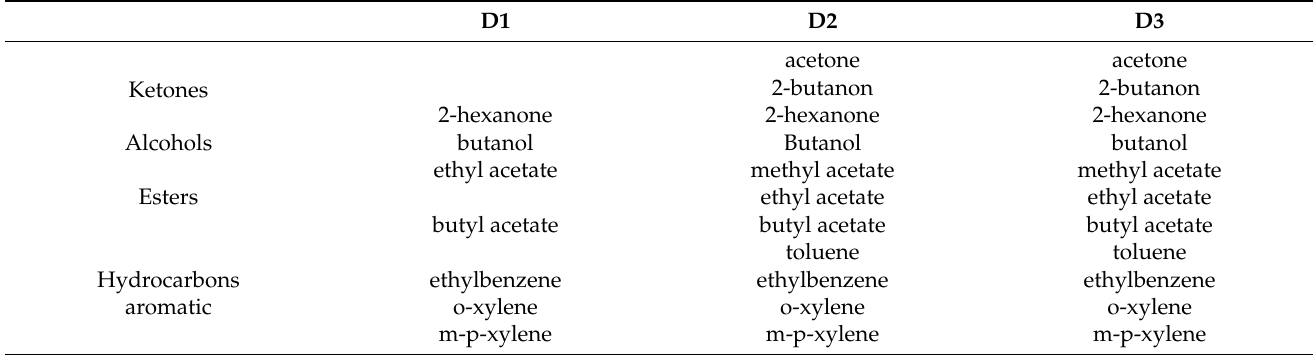
Table 7. Main VOC compounds with the highest concentration detected by GC-MS (D-type samples).